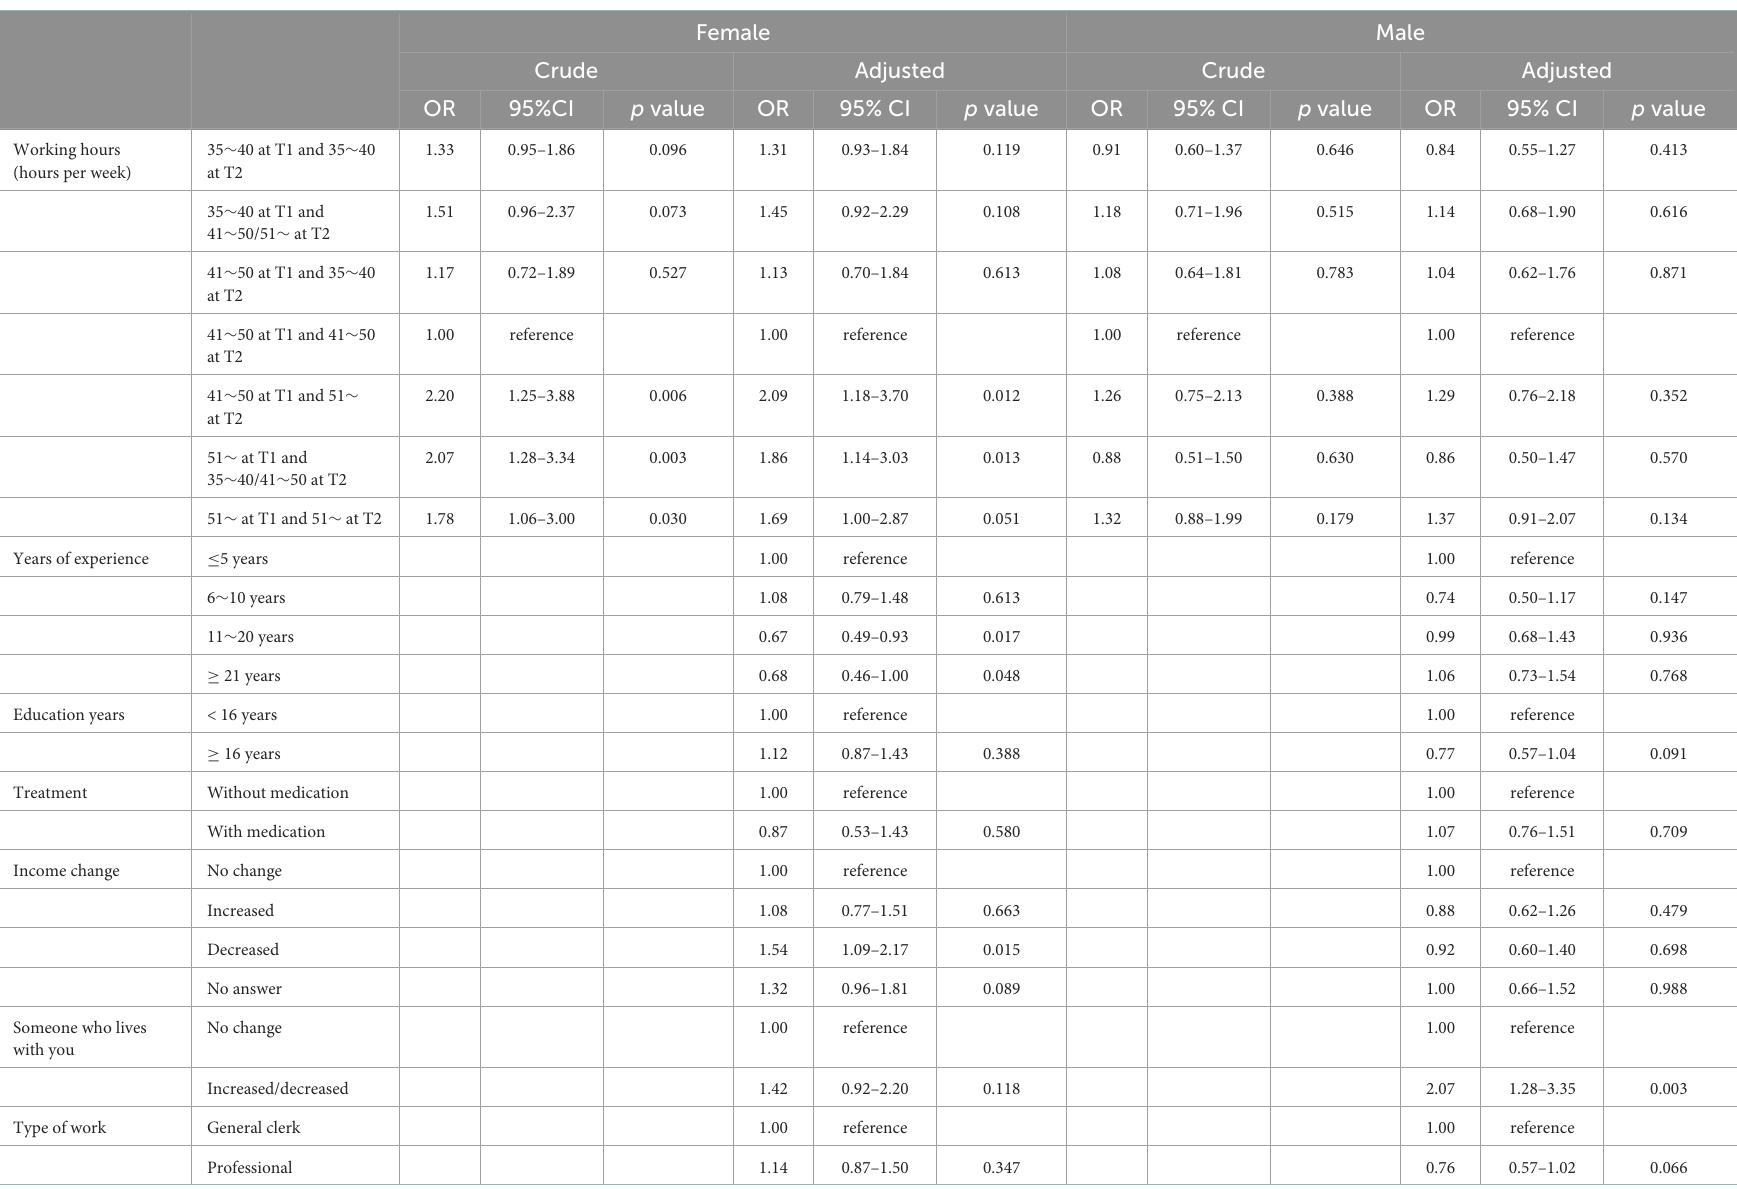
TABLE 3 Estimated odds ratios for high stress based on the Brief Job Stress Questionnaire by